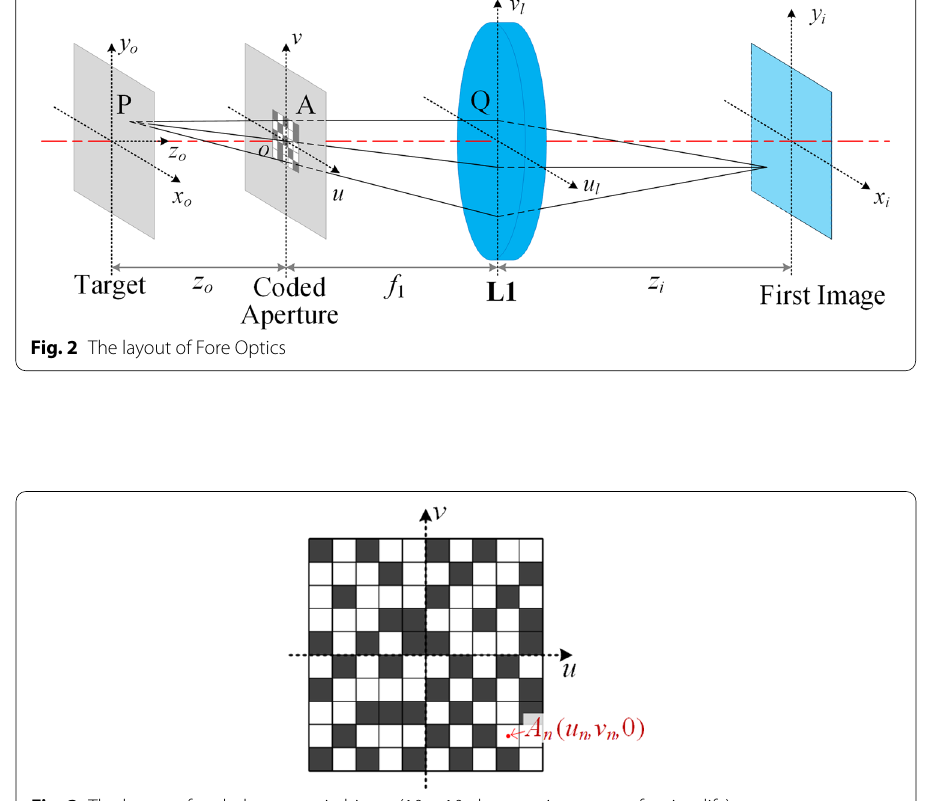
Fig. 3 The layout of coded aperture in binary (10